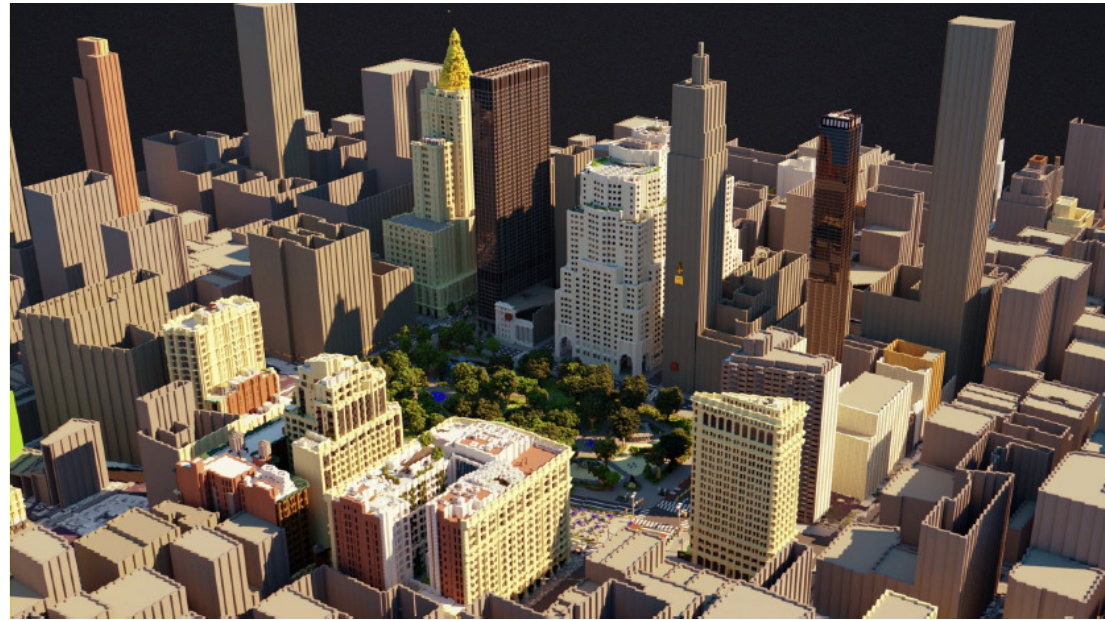
Figure 7. BuildTheEarth New York City. Source: BuildTheEarth